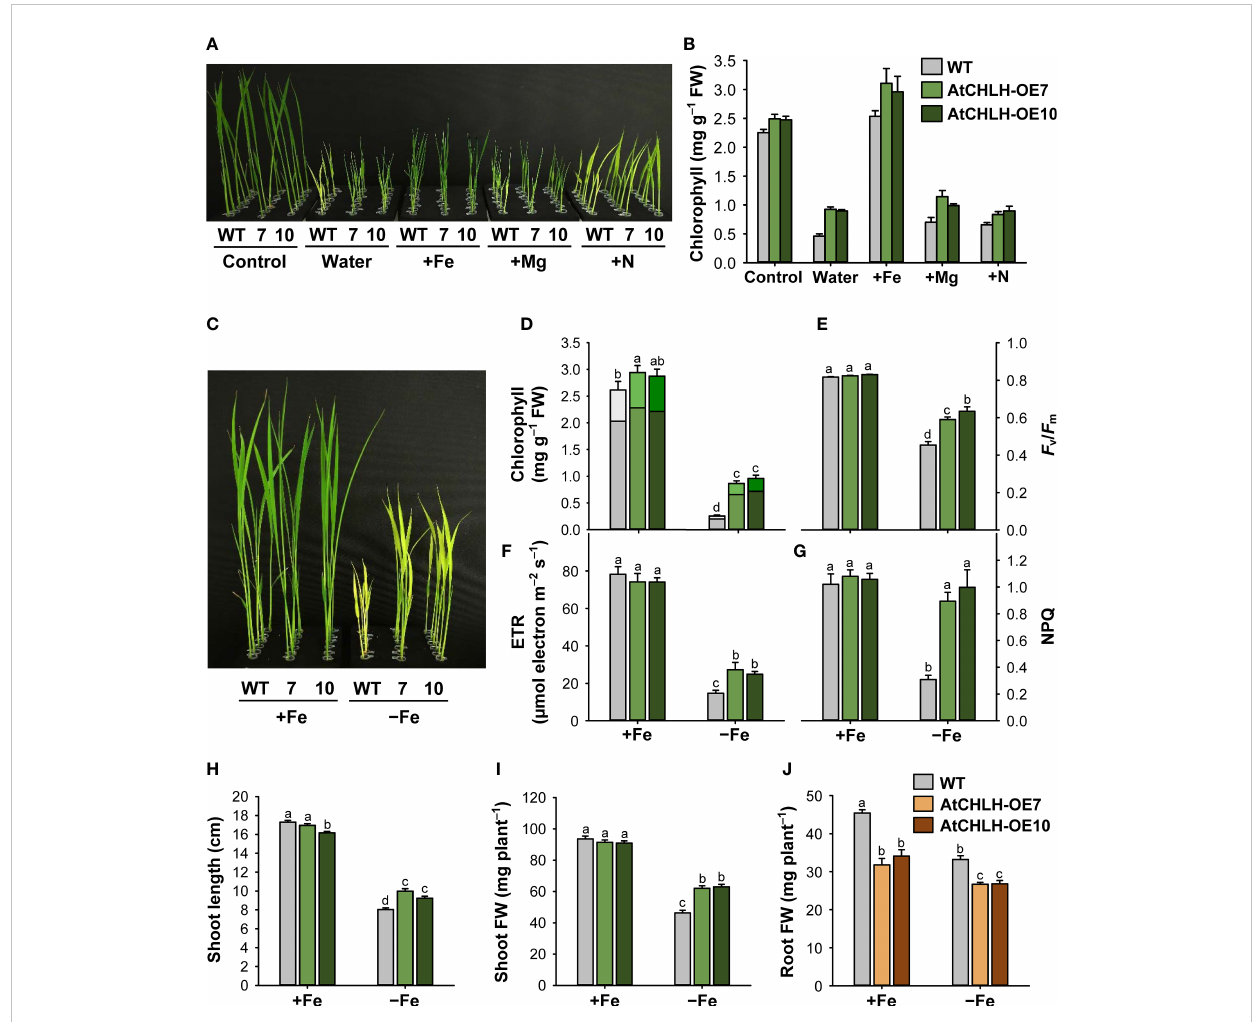
FIGURE 2 Transgenic expression of AtCHLH in rice enhances tolerance to Fe de fi ciency stress. (A, B) Representative phenotypes associated with typical nutrient de fi ciency-related symptoms (A) and chlorophyll contents (B) . WT and transgenic plants were grown hydroponically under different nutrient conditions for 10 days. Control, half-strength Hoagland solution; Water, water only; +Fe, +Mg, and +N, water supplied with 50 µM Fe-EDTA, 0.5 mM MgSO 4 , or 1.25 mM NH 4 NO 3 , respectively. (C – J) Rice plants heterologously expressing AtCHLH are more tolerant to Fe de fi ciency. (C) Fe response phenotypes in WT and AtCHLH -expressing plants after Fe de fi ciency. (D) Chlorophyll contents. Within each bar, lower and upper segments indicate chlorophyll a and b , respectively. (E) Photosynthetic performance ( F v / F m ). (F) Electron transport rate (ETR). (G) Non-photochemical quenching (NPQ). (H) Shoot length. (I) Shoot fresh weight. (J) Root fresh weight. WT and transgenic rice seedlings were transferred to half-strength Hoagland solution without or with 50µM Fe-EDTA for 7 days. Growth characteristics of seedlings were measured and photographs were taken after 7 days of exposure to Fe de fi ciency. AtCHLH-OE7 and AtCHLH-OE10, transgenic lines overexpressing AtCHLH ; +Fe, half-strength Hoagland solution with 50µM Fe- EDTA; – Fe, half-strength Hoagland solution with no Fe-EDTA. Values are means ± SE, and data from three independent experiments are presented. Different letters indicate signi fi cant differences at P < 0.05 by Duncan ’ s multiple range test. FW, fresh